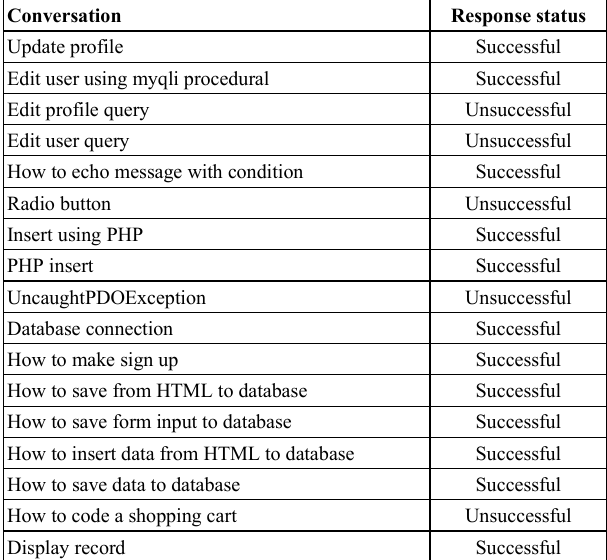
Table 1. Conversation and response